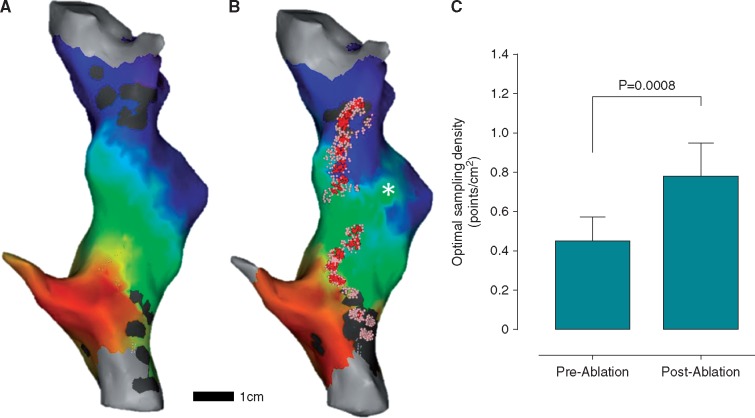
Porcine right atrial LAT maps. (A) Pre-ablation LAT shows uniform activation across the chamber from coronary sinus towards the right atrial appendage. (B) Post-ablation LAT shows a new activation detour (asterisk) via the mid-chamber gap in the ablation line. Ablation points are shown with red tags and catheter positions during ablation with pink dots using the Visitag Carto3 module. (C) Comparison between optimal LAT sampling density for pre- and post-ablation LAT maps.